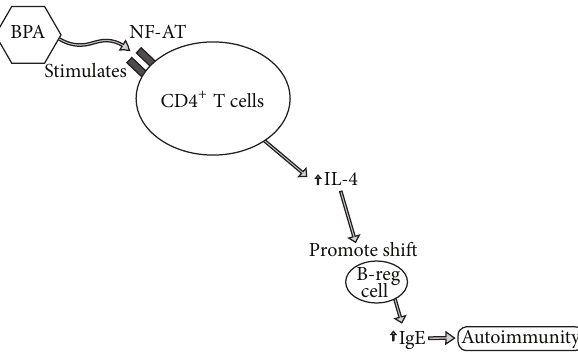
Figure 9: This diagram illustrates how bisphenol A can impact immunoglobulin-promotedautoimmunity.BPA:bisphenolA;B-reg cell: regulatory B cell; IL: interleukin; IgE: immunoglobulin E; NF- AT: Ca2 + /calcineurin-dependent nuclear factor binding